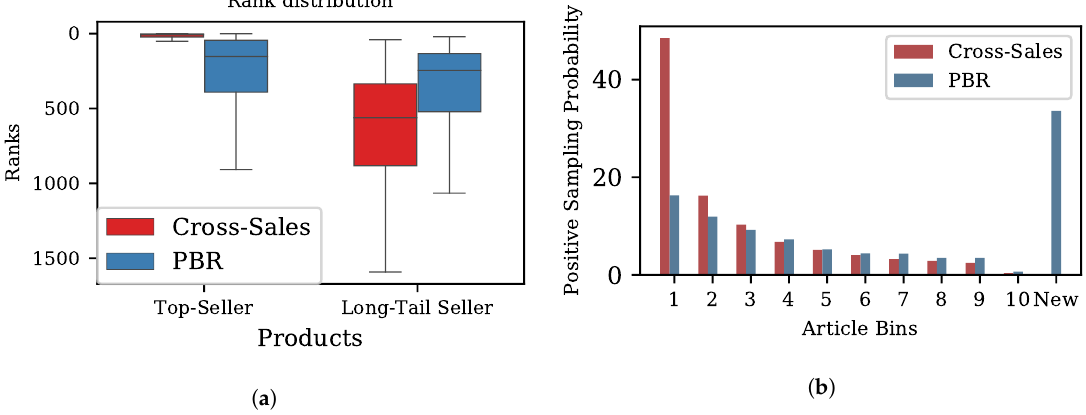
Figure 3. ( a ) Cross-selling rank distribution for a top-selling product and a product from the long tail based on raw cross-sales and the PBR. ( b ) Average probability for products (grouped into 10 quantiles) to be among the top cross-selling articles that are being used for positive sampling in the triplet loss for both approaches. “New” denotes products that are not included in positive sampling in the approach based on raw cross-sales, but are relevant in the PBR approach, and shows their average positive sampling probability. These products show up in addition among top ranked cross-selling products when the PBR is applied. The PBR introduces around 75% more products with an average sampling probability 36.6%. Quantile selection of products for the first 10 product bins for both approaches is based on raw cross-selling statistics